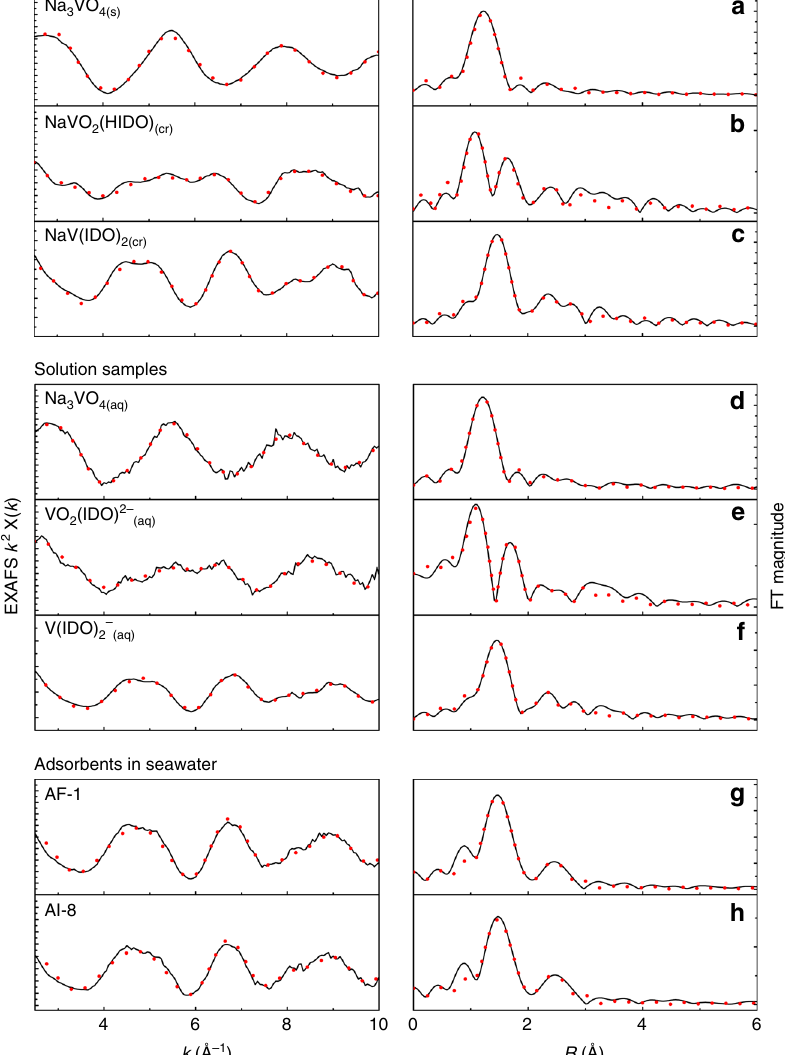
Fig. 4 EXAFS spectra and magnitude of the Fourier transform of small molecule standards, solution samples, and seawater-contacted adsorbents. Solid samples: a Na 3 VO 4(s) . b Na[VO 2 (HIDO)] (cr) . c Na[V(IDO) 2 ] (cr) . Solution samples: d Na 3 VO 4 . e [VO 2 (IDO)] 2 − . f [V(IDO) 2 ] − . Seawater-contacted adsorbents: g AF-1, h AI-8. All samples show the data as a solid black line and fi t as a dotted red